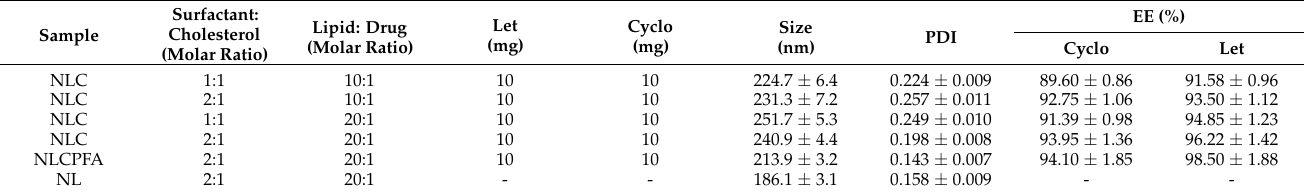
Table 1. Different formulations used for niosomes preparation with their physical properties in- cluding size, PDI, and EE%. In this chart, NL, NLC, and NLCPFA are unloaded, drug-loaded, and functionalized drug-loaded niosomes,